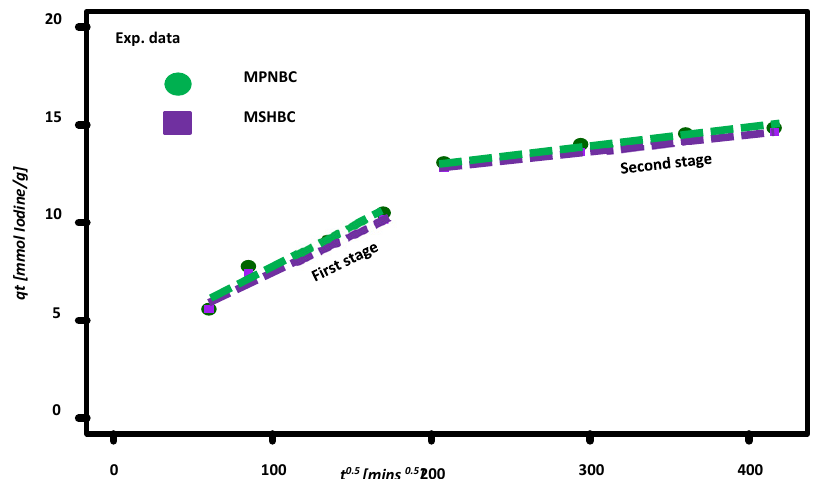
Fig. 5: Illustration of the Intraparticle diffusion model for kinetic adsorption of Iodine onto the Mupane and Mushuma Tree barks biochar measure after 48 hr. of agitation